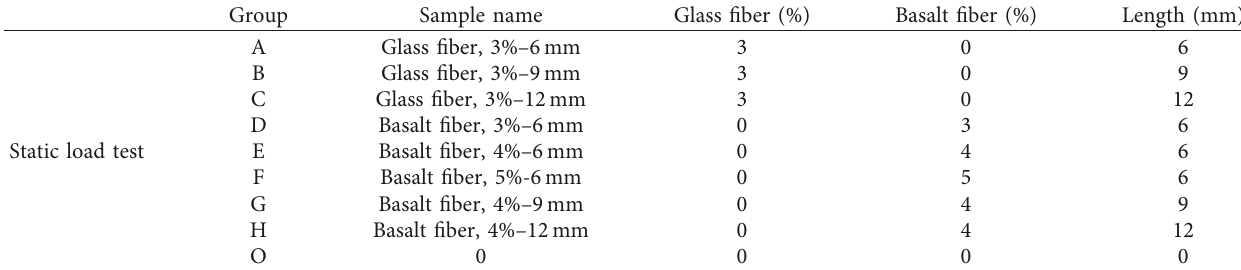
Figure 3: Reinforced glass fiber soil sample and reinforced basalt fiber soil sample. Table 4: Static load test plan.